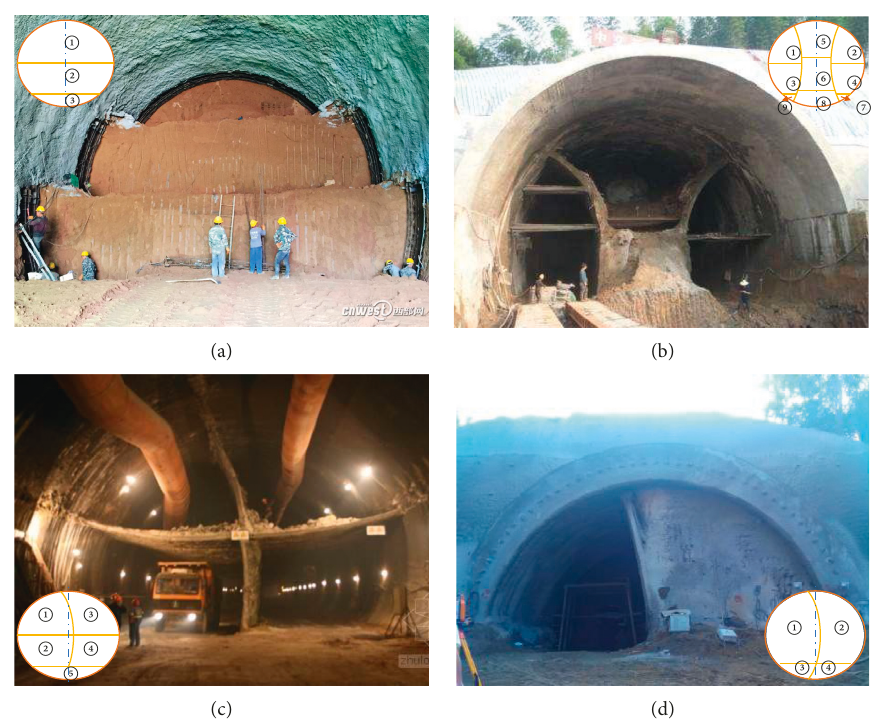
Figure 2: Excavation methods (number is excavation order). (a) BEM. (b) BSDM. (c) CRD. (d)